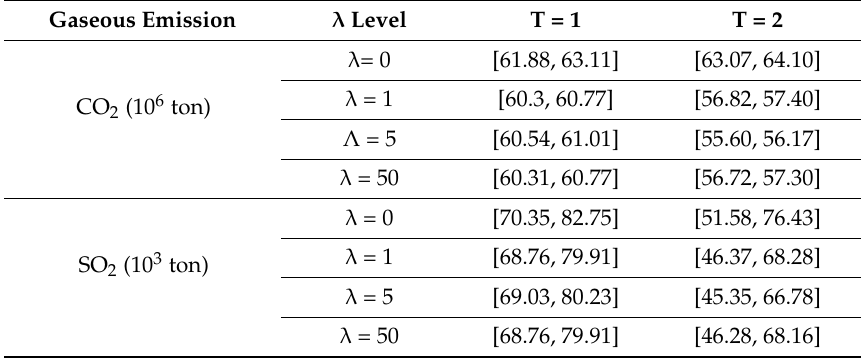
Table 6. The amount of CO 2 and air pollution emissions under different λ